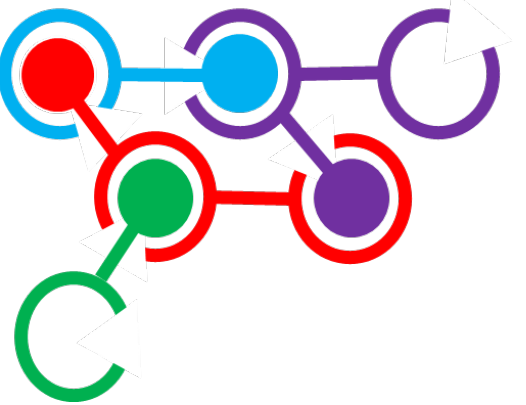
Figure 1. IQ link puzzle game: a metaphor for bringing literature evidence together in a single